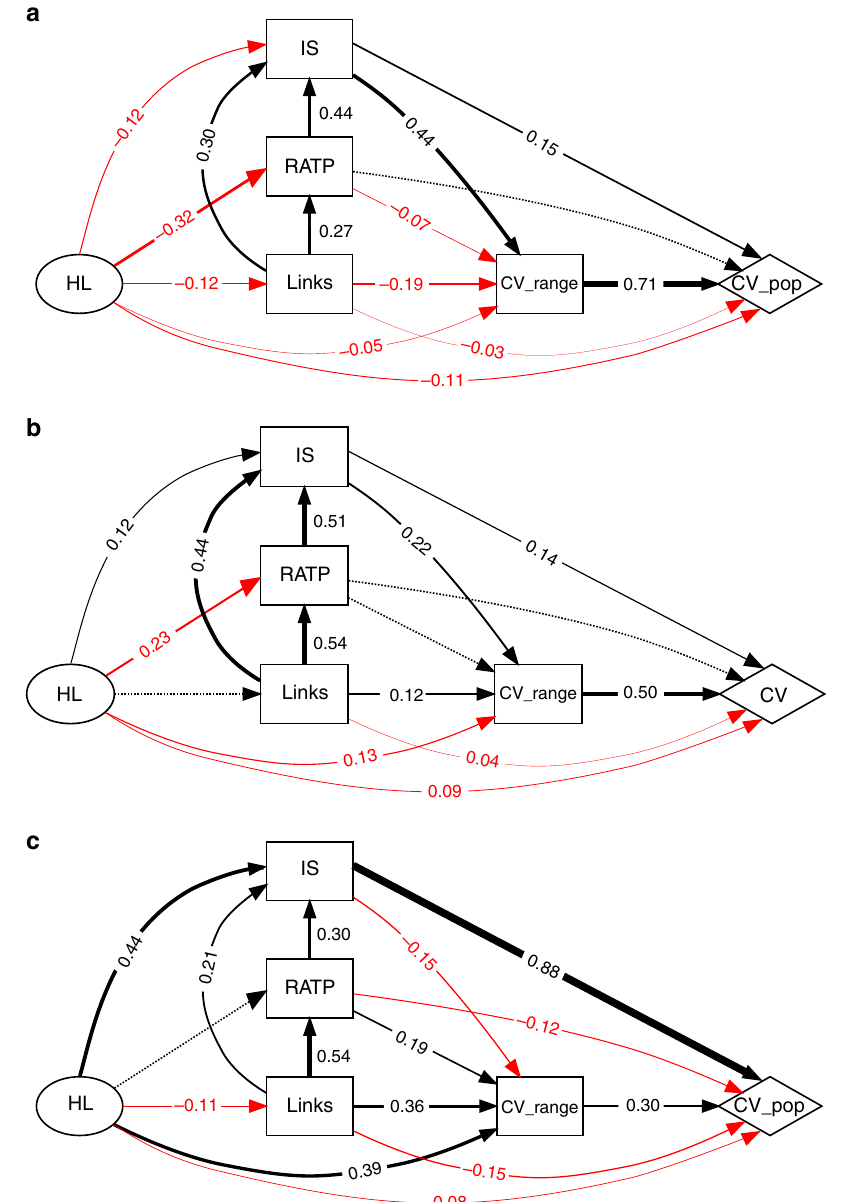
Fig. 4 Structural equation models (SEMs). SEM diagrams show the pathways that in fl uence stability — temporal variability of population abundances and area variability — of multitrophic communities under different types of HL: a random, b intermediate, and c contiguous. Given the small effect to the fraction of mutualism (Supplementary Note 2), we present aggregate results produced by grouping response data for all fractions of mutualism. This aggregation increases the effective number of replicate simulations. Each arrow indicates a link from a predictor to a response variable. Positive effects are shown in black, negative effects in red. Numbers indicate effect size, given by the magnitude of the range-scaled model coef fi cients. Width of solid arrows indicates effect size; dashed arrows indicate non-signi fi cant links. Multiplication of coef fi cients along a given path can be interpreted as a measure of the in fl uence along that path relative to other paths in the